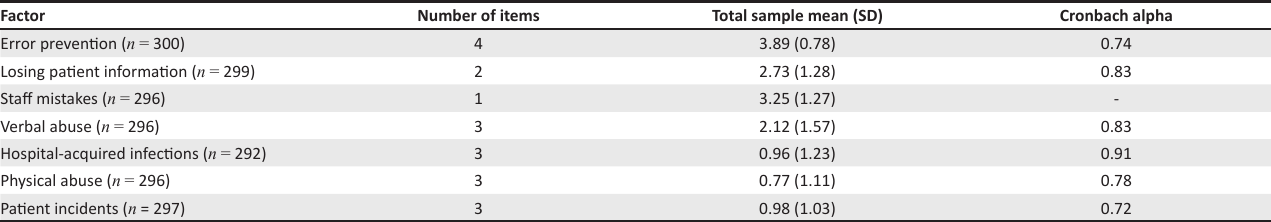
TABLE 1: Mean scores and reliability indices of the factors identified ( N = 304).